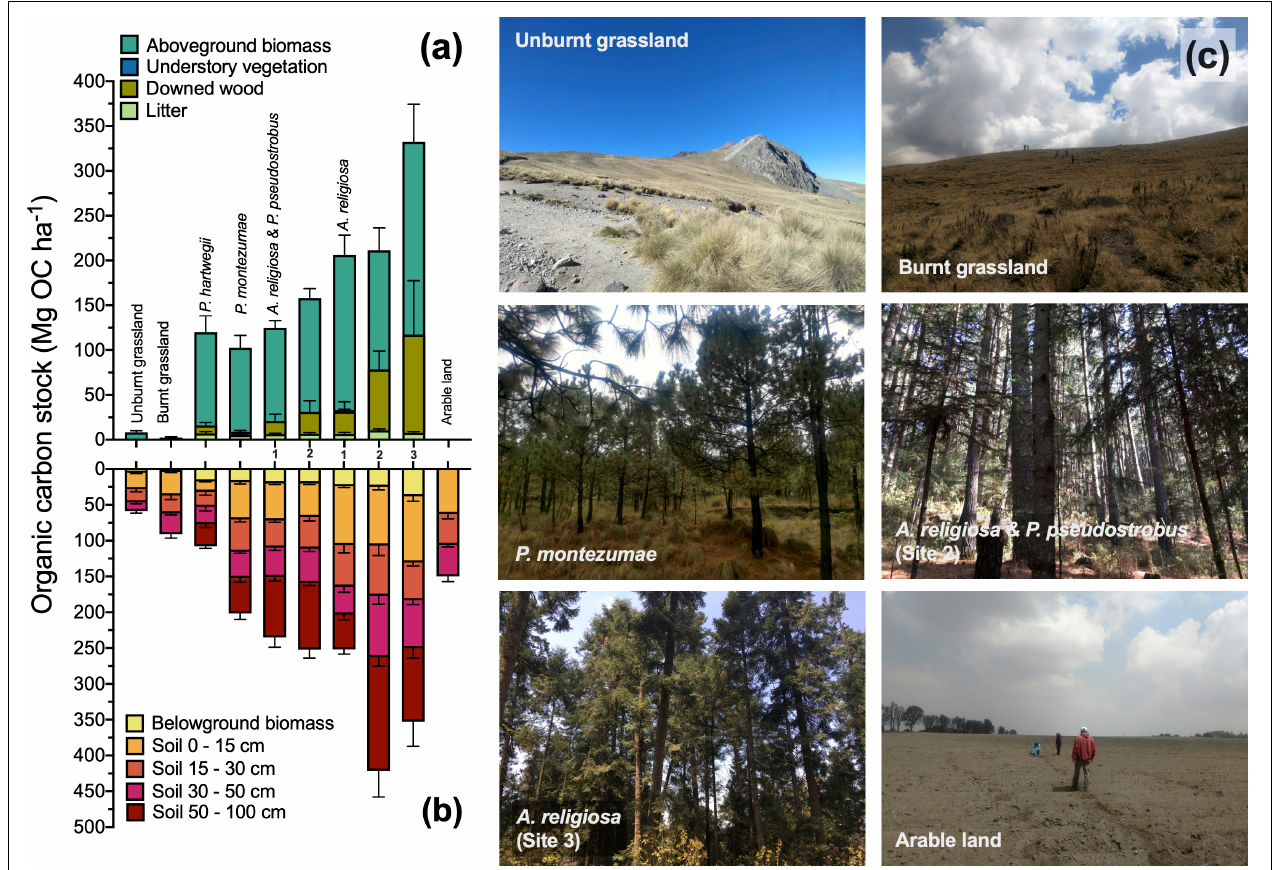
FIGURE 2 | Organic carbon (OC) stocks at our 10 studied habitats from the Nevado de Toluca, Mexico. (a) OC from aboveground biomass, understory vegetation, downed wood and litter when present and (b) OC from belowground biomass, and soil OC at different depths. (c) Examples of our studied habitats, alpine grasslands, P. montezumae , A. religiosa and P. pseudostrobus (site 2), A. religiosa (site 3) and arable land